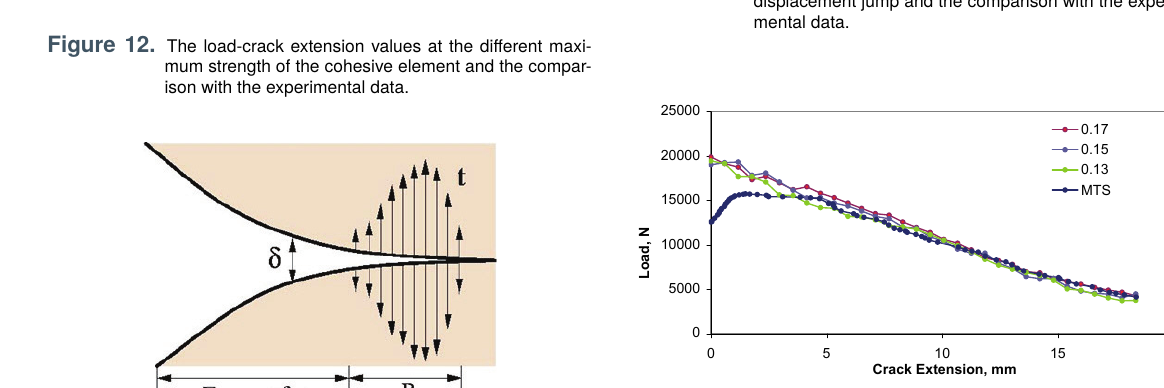
experimental data.